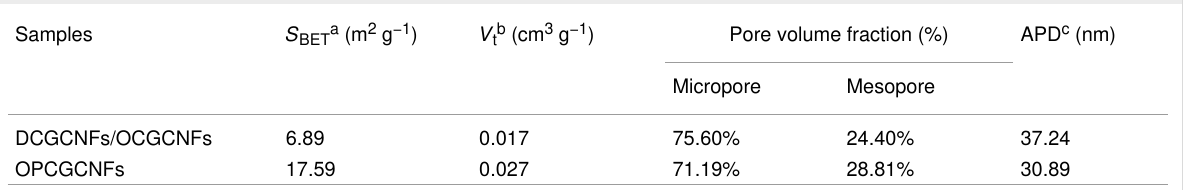
Table 1: Pore characteristics of DCGCNFs/OCGCNFs and OPCGCNFs. Samples